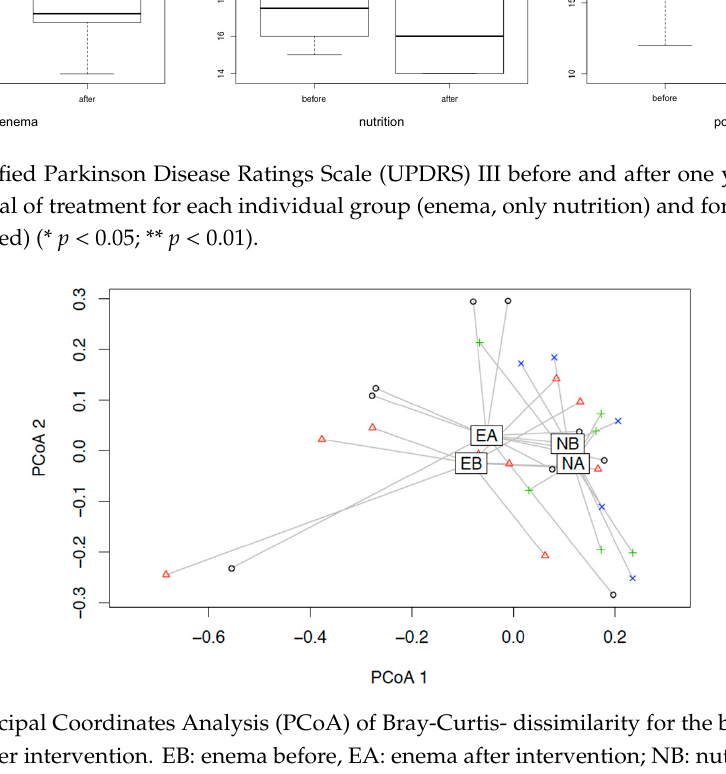
Figure 5. Principal Coordinates Analysis (PCoA) of Bray-Curtis- dissimilarity for the beta-diversity before and after intervention. EB: enema before, EA: enema after intervention; NB: nutrition before, NA: nutrition after intervention.